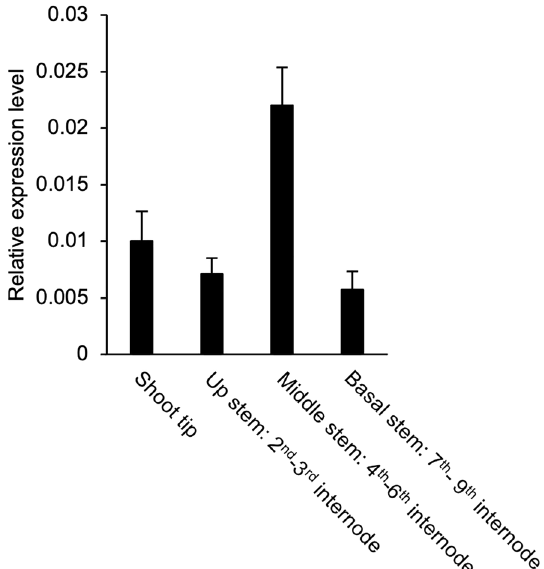
Fig. 2 Relative expression of CWPO-C gene in different parts of the stem in 6‑week‑old WT poplar. Analyses were conducted with three biological replicates (mean standard deviation). Data are presented ± as relative transcript abundance normalized to UBQ expression